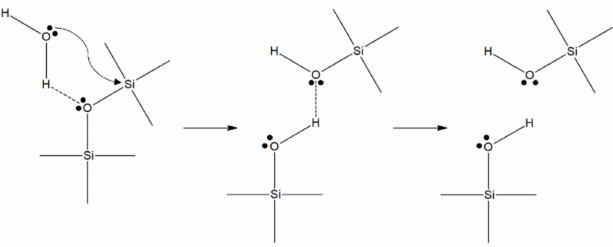
Figure 1. The chemical mechanism of stress corrosion in glass, proposed by Michalske and Freiman